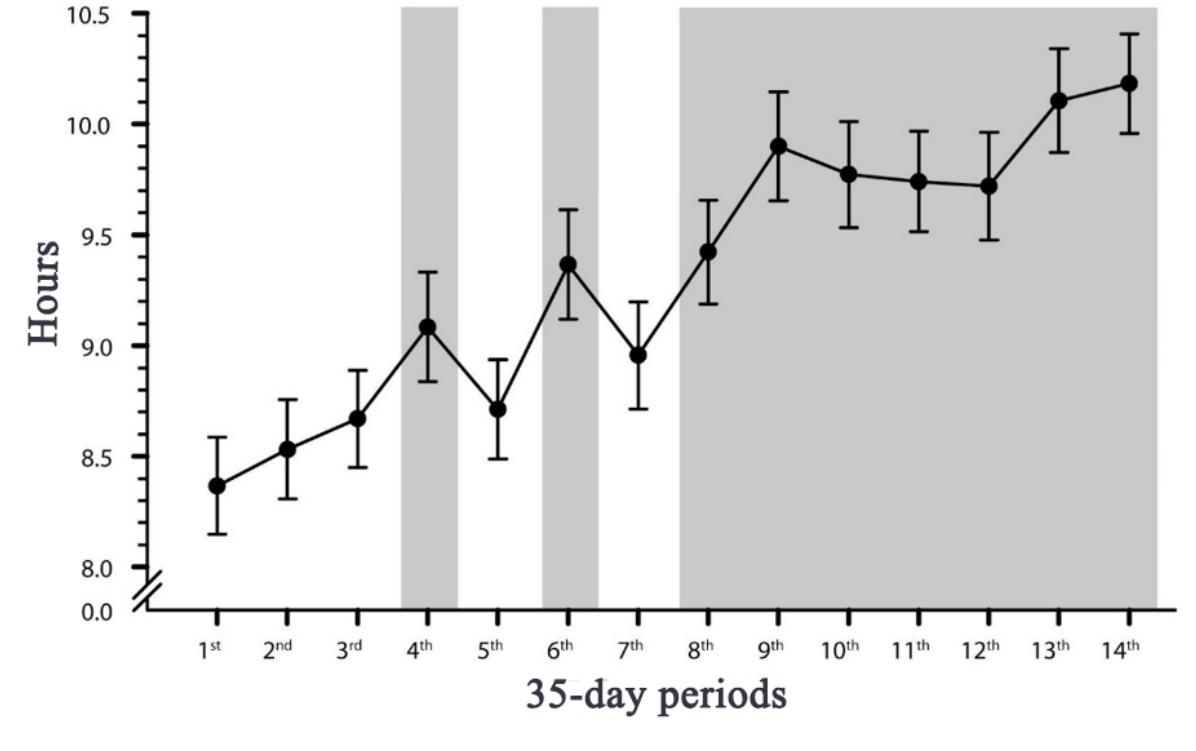
Figure 2. Evolution of estimated means (SE) for hours of sleep detected during the monitoring period. The gray zones highlight statistically significant ( P <.05) periods when compared with the first